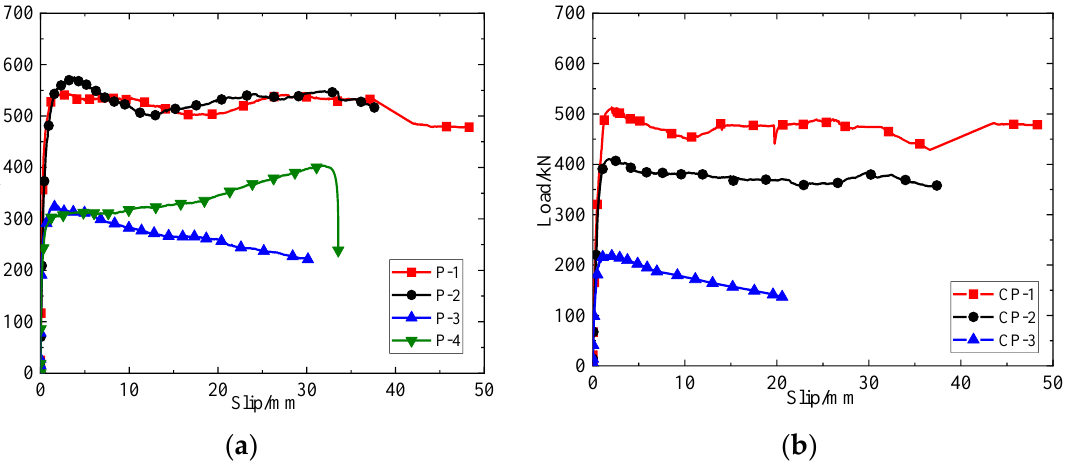
Figure 14. Effect of perforating rebar concrete grade on load–slip curves: ( a ) C60 concrete; ( b ) C40 concrete.